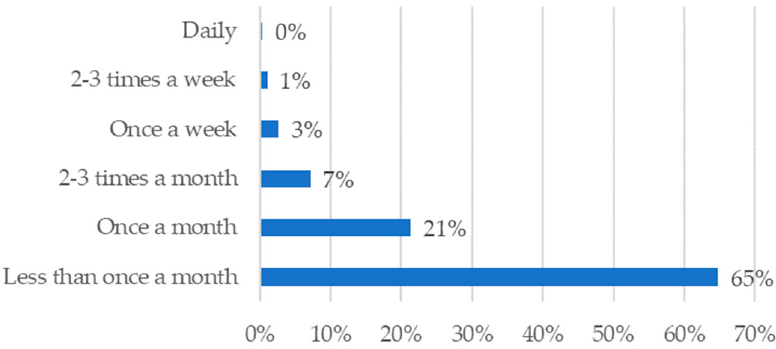
Figure 2. Frequency of insect incorporation.